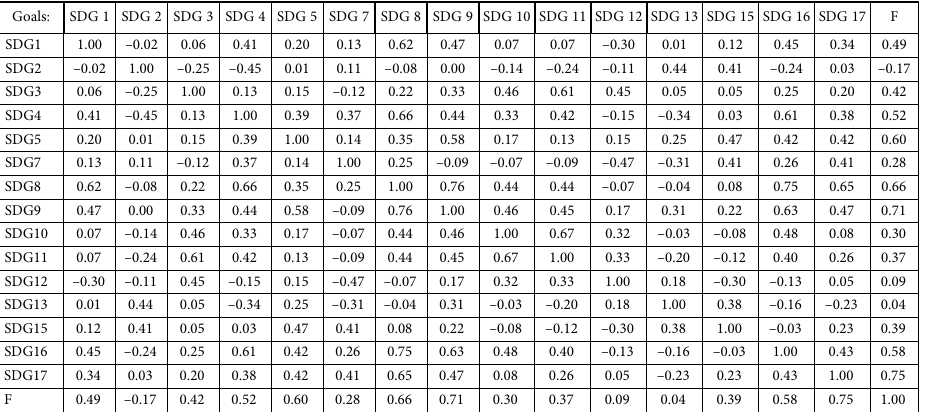
Table 2. Pearson correlation coefficient in the scope of sustainable finance and the selected goals of Agenda 2030 in